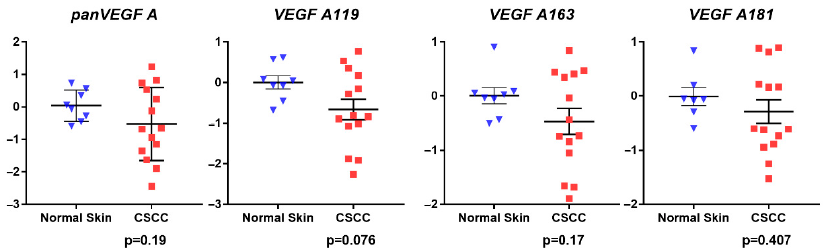
Figure 3. VEGF-A relative gene expression. mRNA expression of panVEGF-A and the indicated splice variants was estimated by qRT-PCR in cDNAs derived from FFPE sections of NHS and CSSC tissue. Results are shown as relative to mean 18S rRNA-normalized expression in NHS controls, calculated using the ΔΔ Ct method. Vertical axes represent expression in CSSC relative to NHS on a log 10 scale. Blue triangles represent normal skin samples; red squares represent CSCC samples. p values are from two-sided unpaired Student’s t -tests.